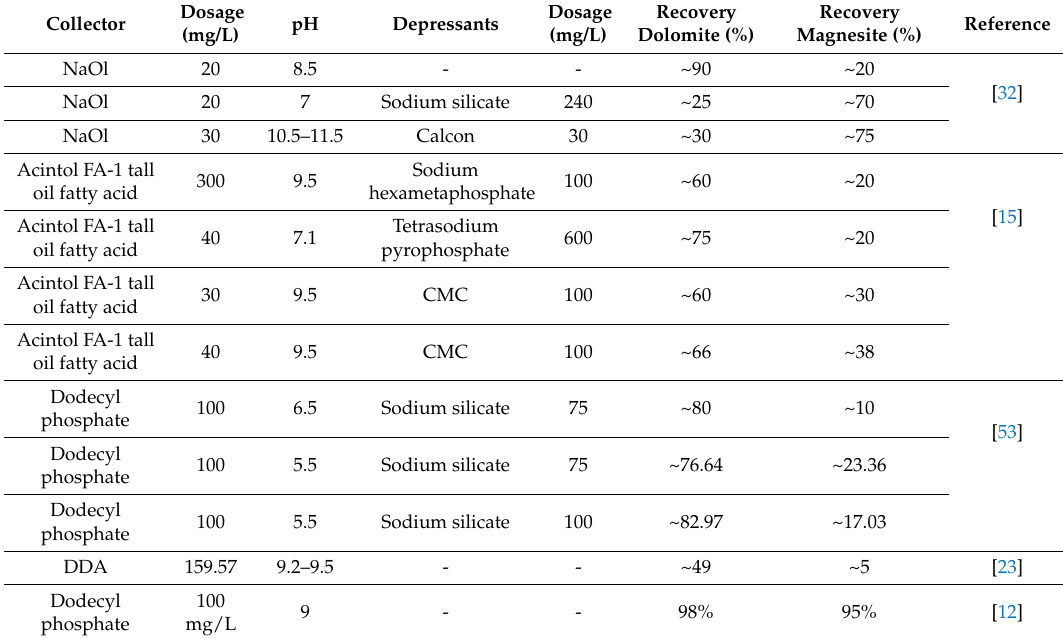
Table 5. Various conditions for flotation separation of dolomite from